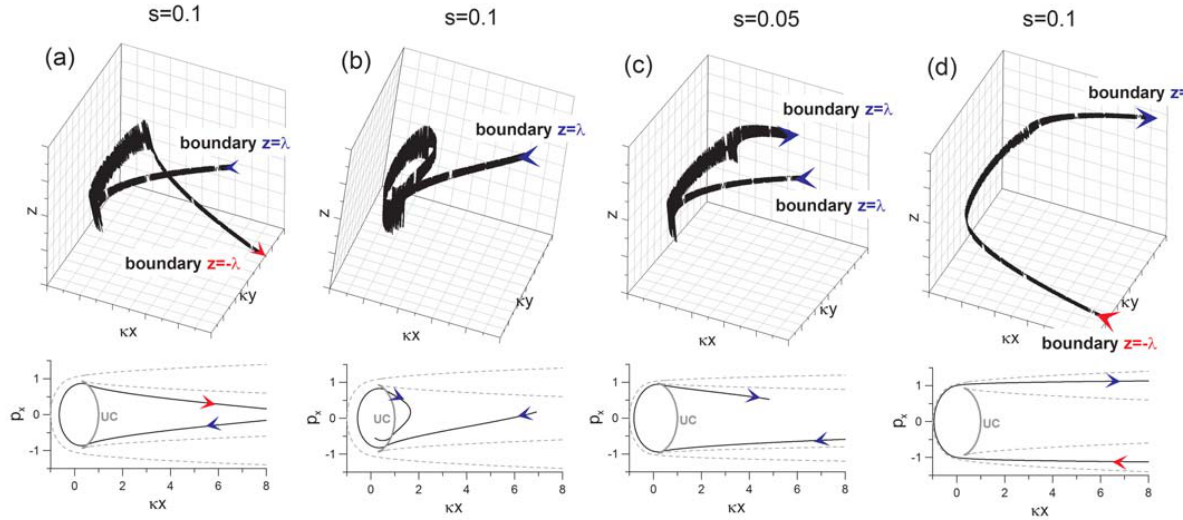
Fig. 4. Four types of trajectories and their projections onto the (κx,p x ) plane.